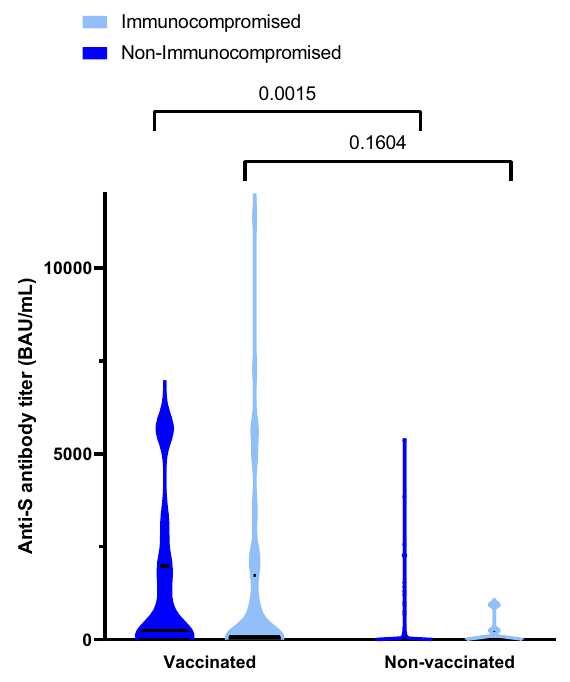
Fig. 5 | Serum anti-spike (S) antibody titers in vaccinated and non-vaccinated, immunocompromised (light blue) and non-immunocompromised (deep blue) patients. Bytwo-wayANOVA,therewasasigni fi canteffectofvaccinationonanti-S titers ( p =0.0023), no signi fi cant effect of the immunocompromised status ( p =0.6023)andnosigni fi cantinteractionbetweenbothparameters(vaccinationx immunocompromised status; p =0.9824); Data distribution is represented using violin plots; Horizontal bars show median and quartiles 25 and 75; Displayed p - values have been obtained with the Sidak ’ s post-hoc test.; BAU Binding Antibody Units, Source data are provided as a Source Data fi